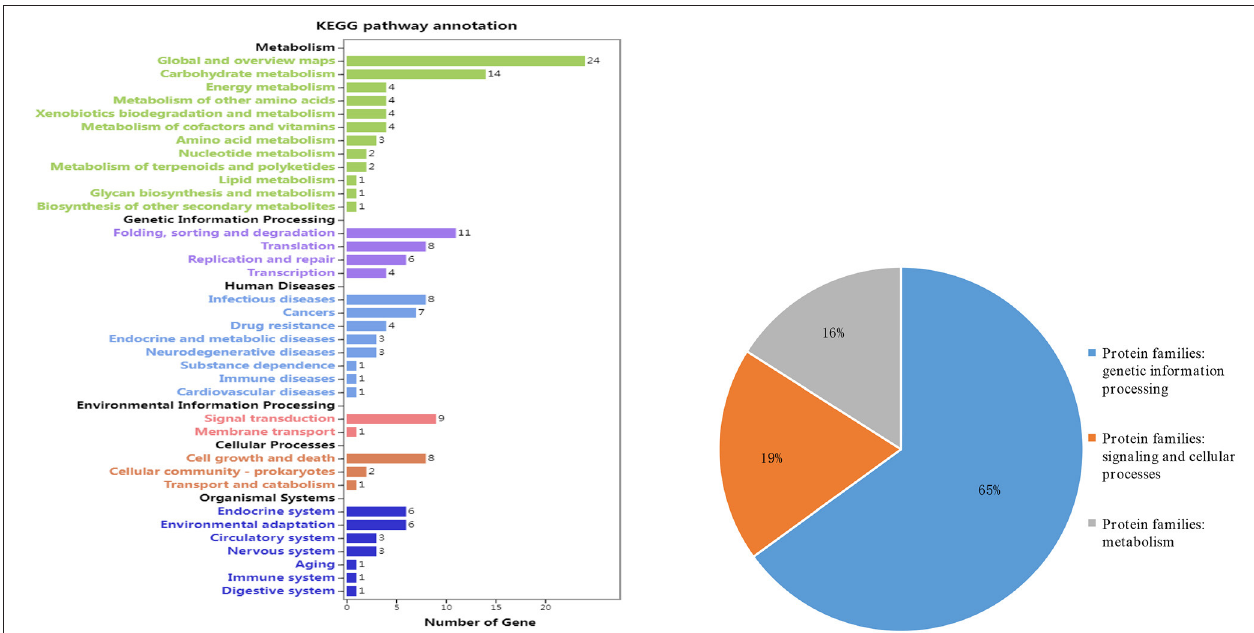
FIGURE 6 | Information on pathways (left) and orthologous protein families (right) of main stem node number (MSNN)-annotated candidate genes.